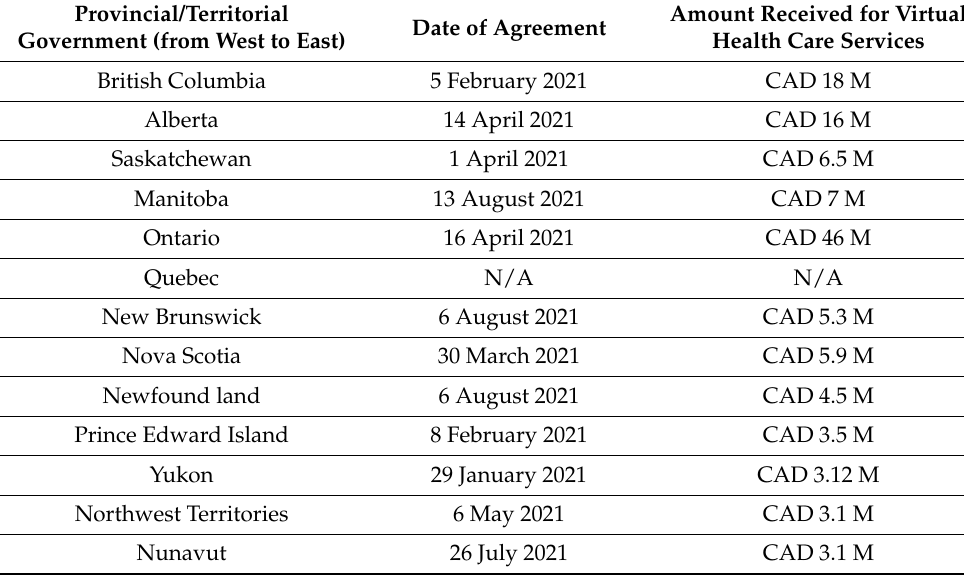
Table 1. Bilateral agreements between the Federal and Provincial/Territorial governments of Canada to receive funding to expand virtual health care services